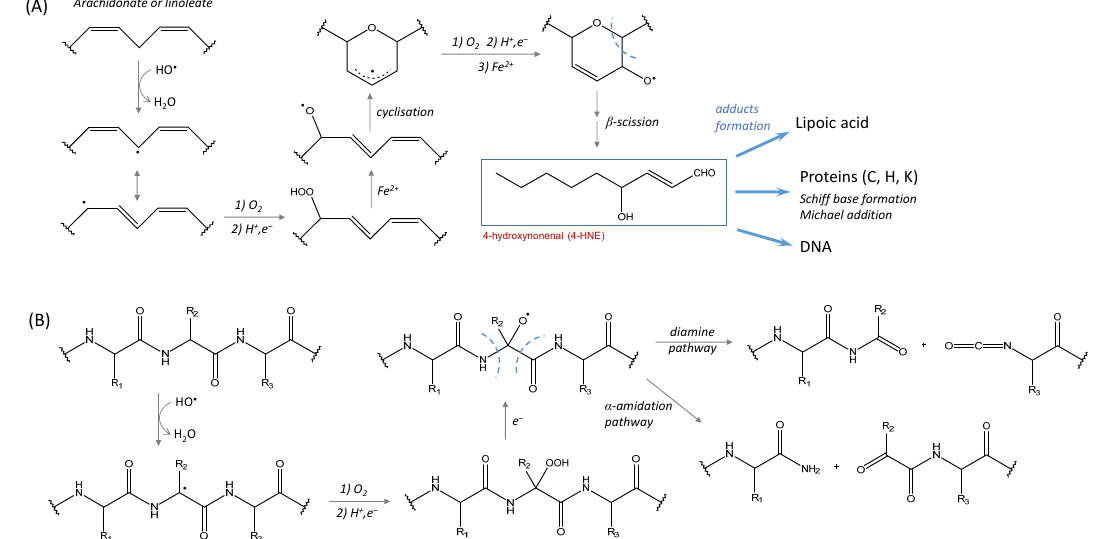
Figure 5. The direct involvement of ROS in lipid peroxidation and protein carbonylation. ( A ) the mechanism of 4-HNE formation from ROS-induced polyunsaturated omega-6 fatty acid peroxidation (from Pryor and Porter [125]); 4-HNE is able to form adducts with lipoic acid, proteins (C, H and K residues) and DNA bases; ( B ) ROS-induced protein carbonylation and cleavage (from Stadtman and Levine [43]).